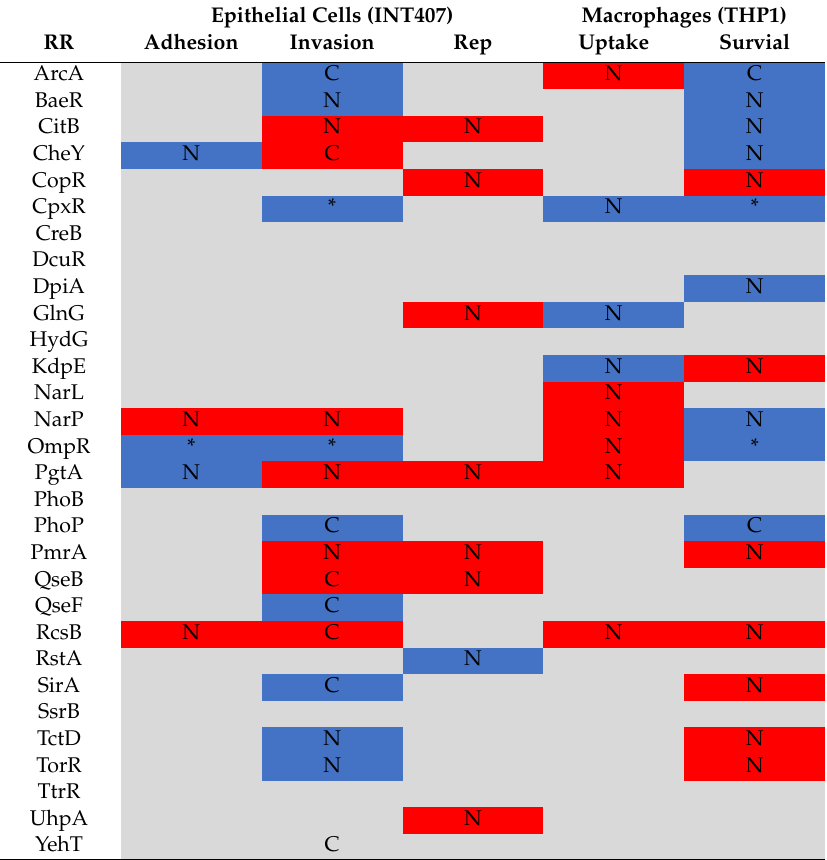
(Figure 6). No significant di ff erence between the wild-type was observed, confirming a di ff erence in the role of CpxR between S. Typhi and S . Typhimurium. Table 2. Phenotype of regulator mutant during interaction with